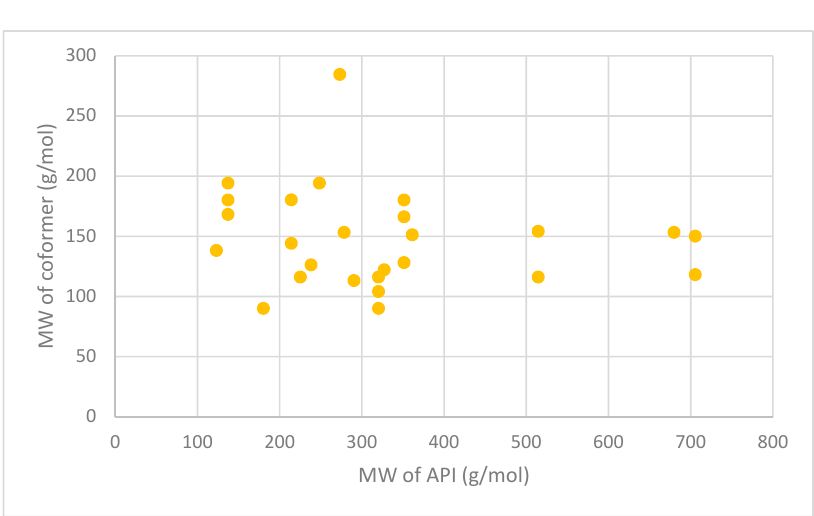
Figure 4. A scatter graph of the data from Table 8 comparing the molecular weights of the APIs and their coformers.